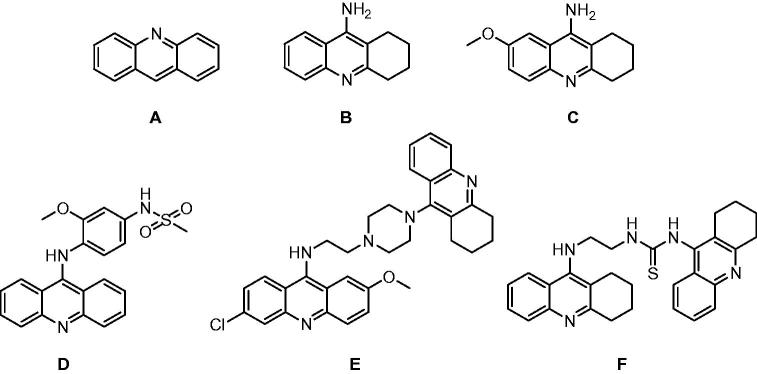
Chemical structures of acridine (A), THA (B) and their derivatives: 7-MEOTA (C)5, mAMSA (D), 6-chloro-2-methoxy-N-{2-[4-(1,2,3,4-tetrahydroacridin-9-yl)piperazin-1-yl]ethyl}acridin-9-ylamine (E)35, 1-(1,2,3,4-tetrahydro-acridin-9-yl)-3-[2-(1,2,3,4-tetrahydroacridin-9-ylamino)ethyl]thiourea (F)35.